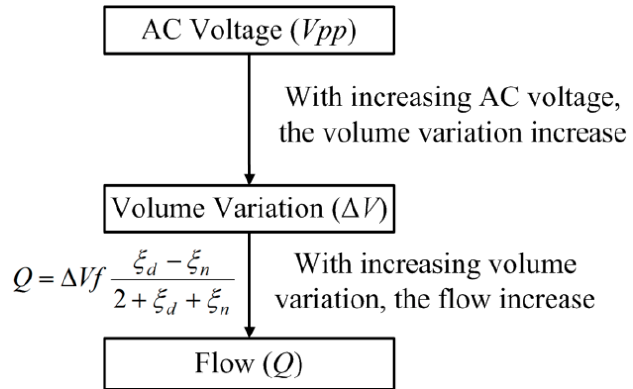
Figure 3. Conceptual plot of alternating current (AC) voltage, volume variation, and flow.